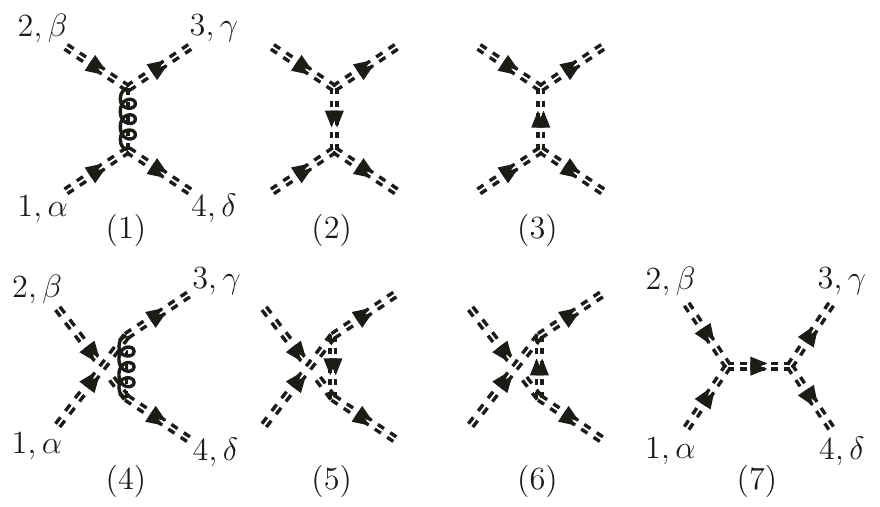
Figure 5 . Seven separate contributions to tree amplitudes with four massive scalars. Dashed lines with arrows denote complex (massive) scalars. In diagram (1) and (4) the exchanged particle is a sum of a massless scalar and a